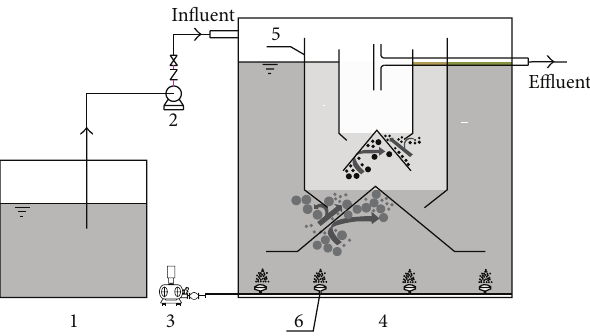
Figure 1: Experimental setup of the decentralised sewage treatment reactor (DSTR): 1, influent plastic tank; 2, peristaltic pump; 3, aeration pump; 4, DSTR reactor; 5, sludge sedimentation device; 6,